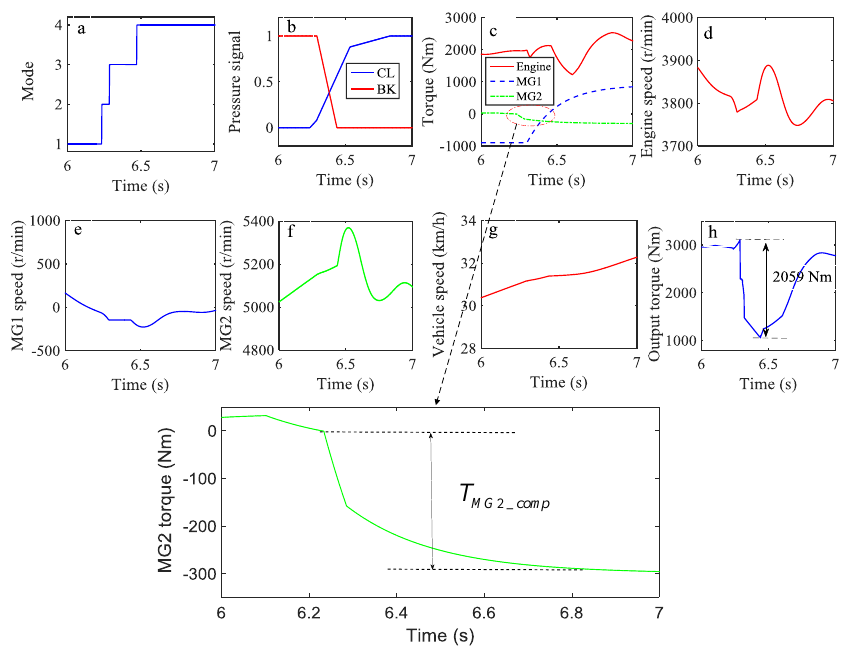
Figure 16. Mode shift characteristics of the hybrid HDV with MG2 torque control: ( a ) mode; ( b ) pressure signal; ( c ) torques of engine and MGs; ( d ) engine speed; ( e ) MG1 speed; ( f ) MG2 speed; ( g ) vehicle speed; and ( h ) output torque.